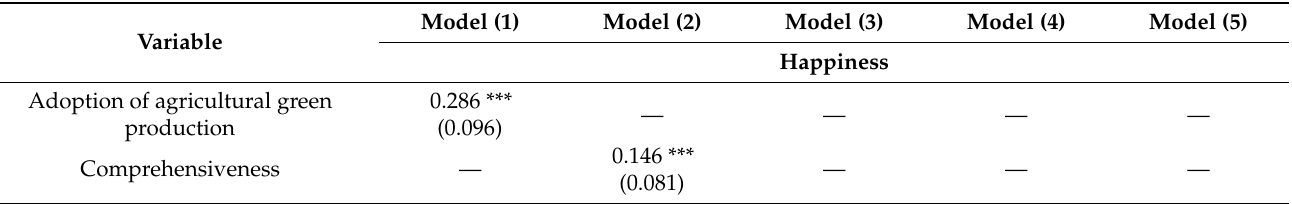
Table 2. Estimation results of the direct impact of adopting agricultural green production on the happiness of